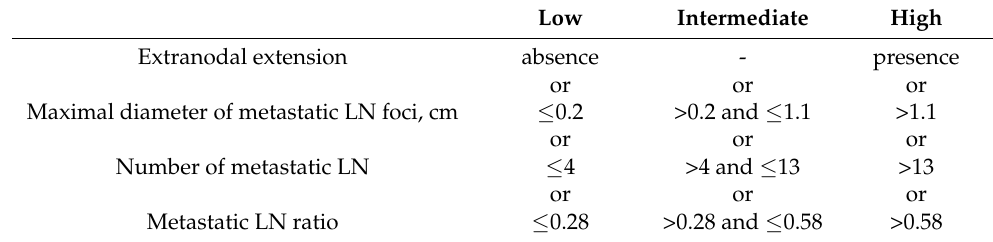
Table 3. Proposal of detailed lymph node-related risk categories for recurrence-free survival. Low Intermediate High Extranodal extension absence - presence